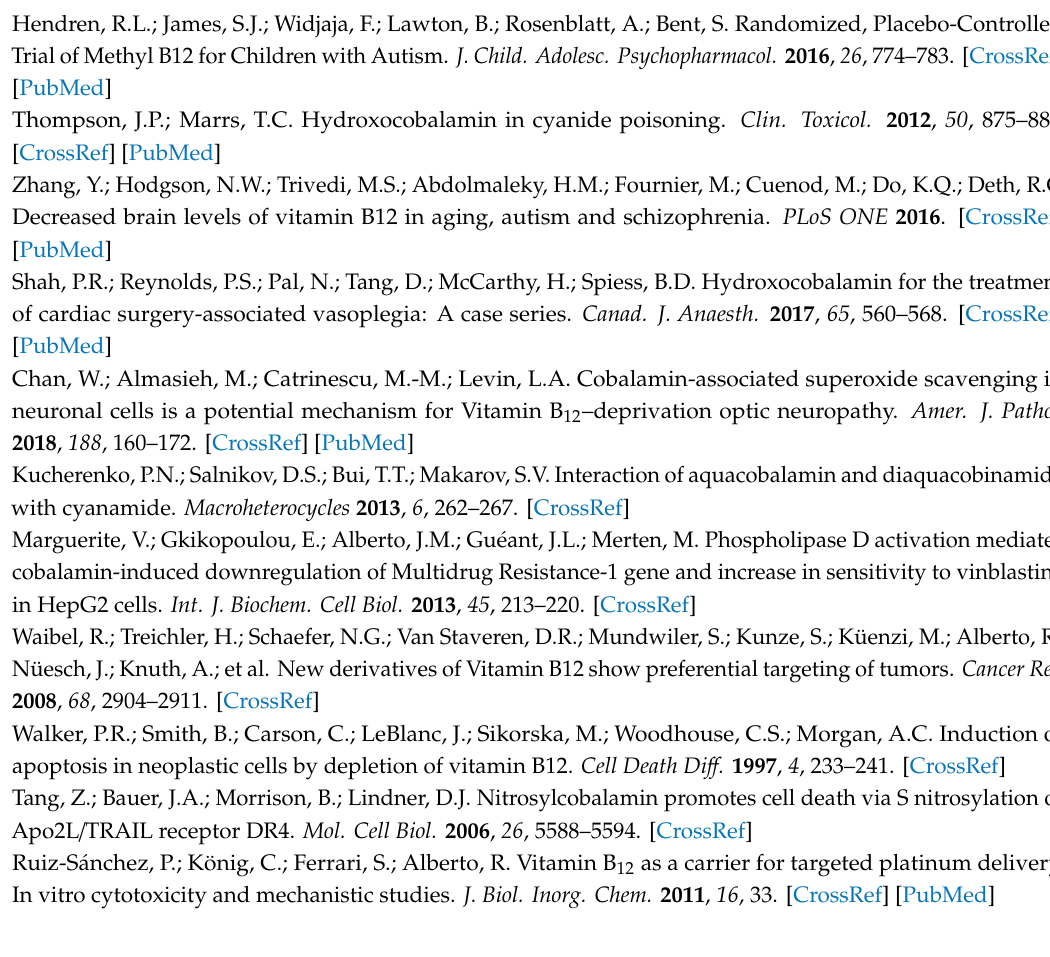
Figure S1: Vacuolization of A431, HT29, and A549 cells at the stage of death initiation by the combination of 1 mM DDC + 25 µ M B 12b ; Figure S2: Nuclear pores (np) are retained during ER swelling (vacuolization) induced by incubation with DDC + B 12b ; Figure S3: The absence of signs of apoptosis during initiation of A549 cell death by a combination of 1 mM DDC with 25 µ M B 12b ; Figure S4: Autophagy inhibitors did not protect HEp-2 cells from vacuolization during the 6-h incubation with DDC + B 12b ; Figure S5: Absence of the signs of autophagy and the involvement of lysosomes in the induction of death of A549 cells by the combination 1 mM DDC + 25 µ M B 12b ; Figure S6: Immunoblot analysis of ER-stress markers in HEp-2 cells after 24-h incubation with 2 µ M